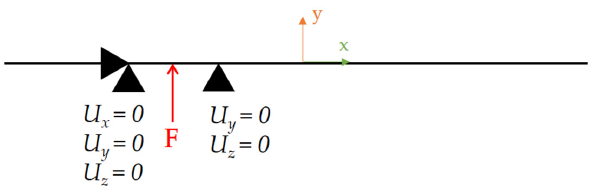
Figure 13. Initial and final shapes of two exemplary billets from operational experiments: “single- arc” type ( a ) and “S-shaped” type ( b ).